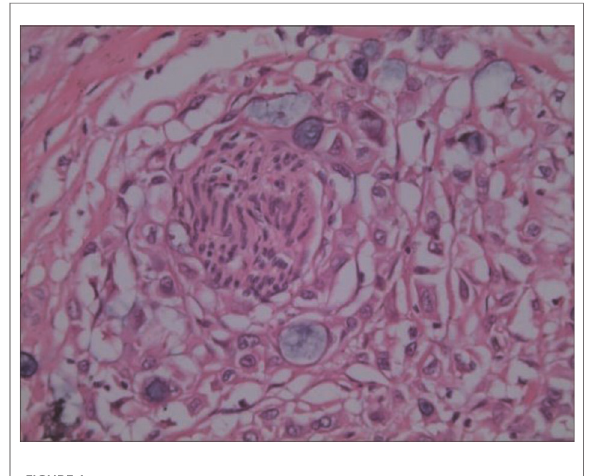
FIGURE 2 Pathological changes of swollen soft tissue in the right